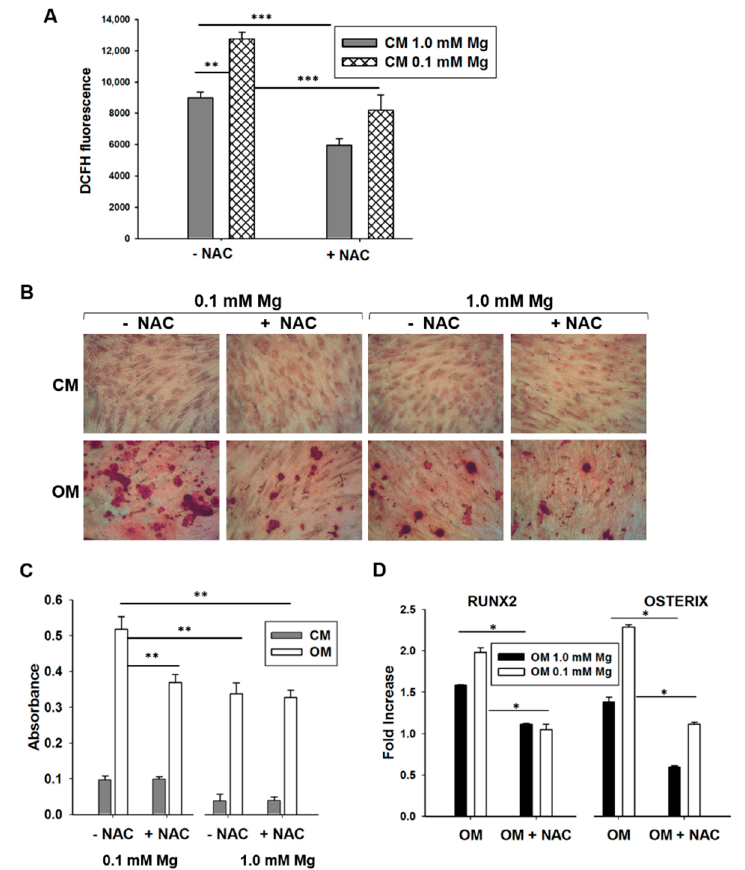
Figure 4. Relationship between Mg withdrawal and reactive oxygen species (ROS) generation. ( A ) Bone marrow mesenchymal stem cells (BM-MSCs) were cultured in 1 mM Mg or in Mg-deprived medium and exposed to control medium (CM). The cells were then treated with N -acetylcysteine (NAC, 1 mM) for 24 h. ROS generation was measured. Data are shown as the mean of three separate experiments ± standard deviation. ** p < 0.01, *** p < 0.001. ( B ) BM-MSCs were cultured in 1 mM Mg or in Mg-deficient medium and exposed to CM or to osteogenic medium (OM). The cells were then treated with NAC (1 mM) for 14 days. Alizarin Red S staining was performed, and photographs were taken at 10× magnification. ( C ) The absorbance of Alizarin Red S staining was measured at 550 nm. ** p < 0.01. ( D ) BM-MSCs were cultured in 1 mM Mg or in Mg-deficient medium and exposed to CM or OM. The cells were then treated with NAC for 4 days. Real-time PCR was performed three times in triplicate on RNA extracted using primers designed on RUNX2 and OSX sequence. All the values were normalized with respect to their controls cultured in CM. The results are the mean of three experiments in triplicates. * p < 0.05.